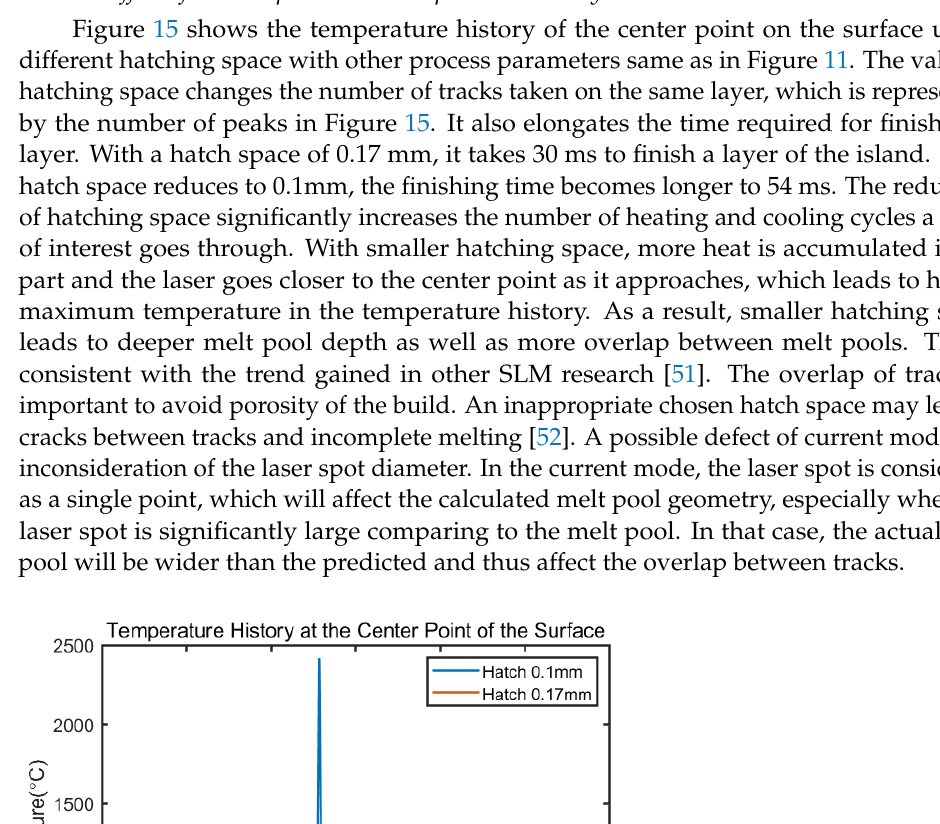
Figure 14. Predicted melt pool depth with different rotational angle between layers applied.